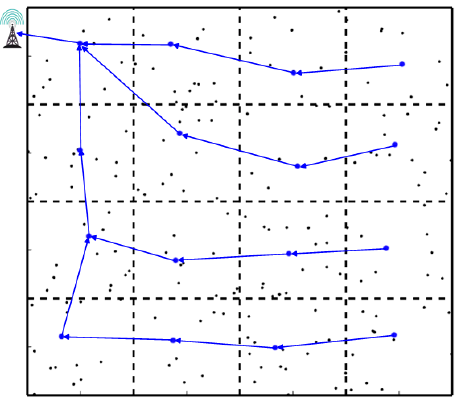
Figure 1. Clustering-based schema with a fixed sink.